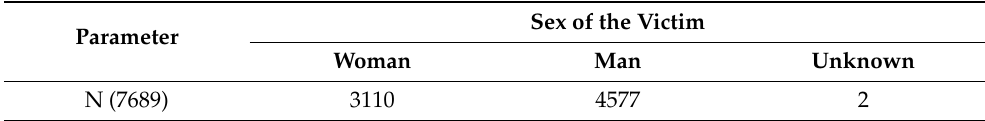
Table 4. Incident distribution by victim sex.